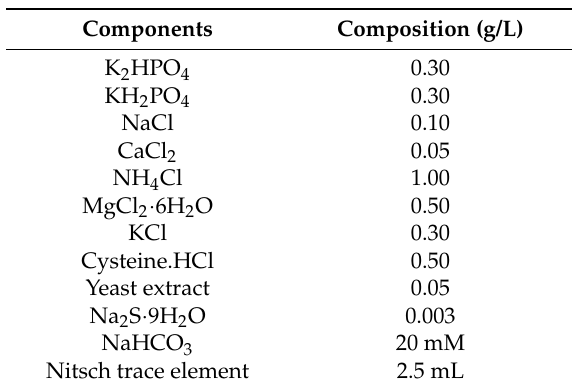
Table 1. The composition of the anaerobic culture medium.